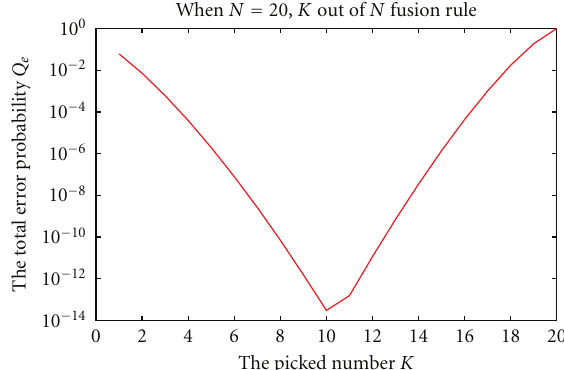
Figure 7: Total error probability versus value K when N = 20.